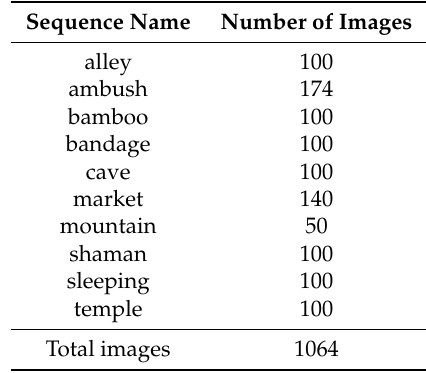
Table 1. Number of images in each image